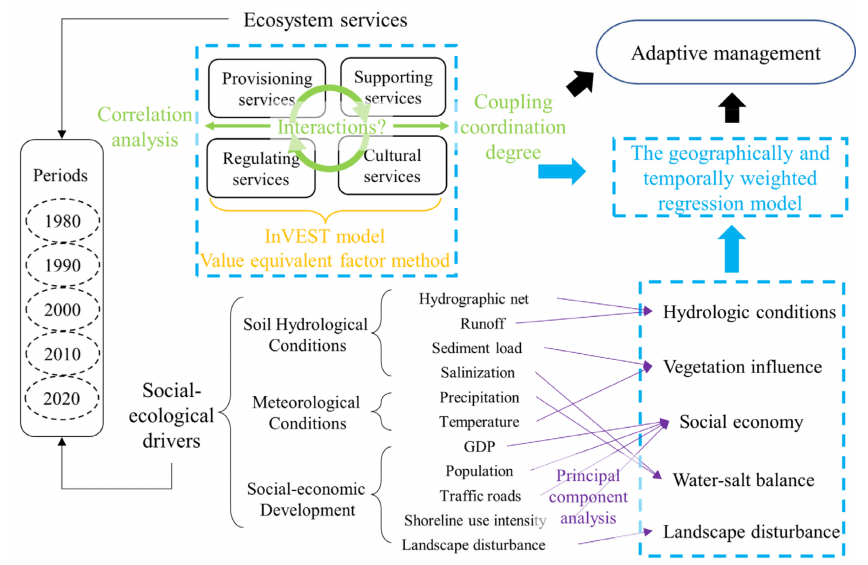
Figure 1. Research framework diagram. Green symbols represent the estimation method of the inter- action of ecosystem services; yellow symbols represent the estimation method of ecosystem services; purple symbols represent principal component analysis; blue symbols represent geographically and temporally weighted regression